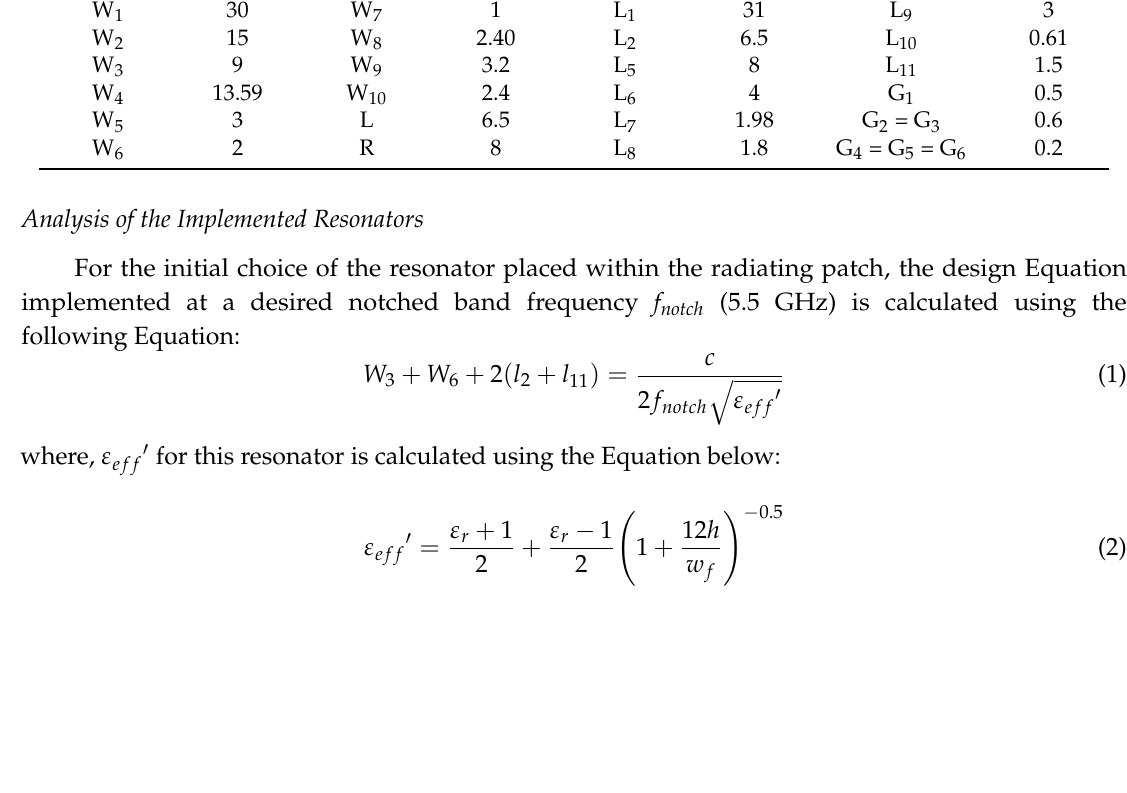
Figure 2. ( a ) Band-notched UWB antenna (Antenna 1) and ( b ) Bluetooth integrated UWB antenna (Antenna 2 when no capacitors are integrated into the resonator and Antenna 3 when the capacitor = 0.5 pF). Table 1. Dimensions of the UWB band-notched antenna with integrated Bluetooth (all values are in mm). Parameter Value Parameter